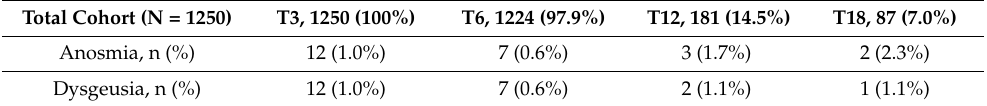
Table 2. Anosmia and dysgeusia of the study population at FUP T3, T6, T12, and T18.